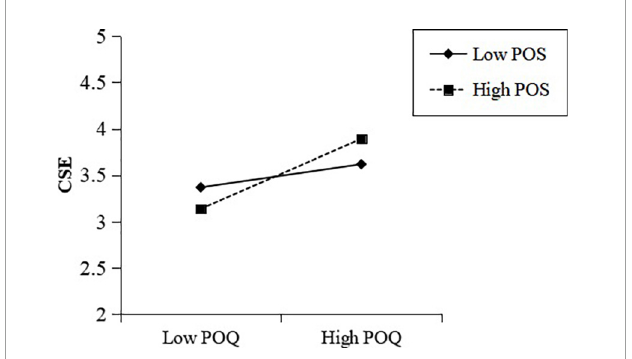
FIGURE2 Moderating effect of POS on the relationship between POQ and